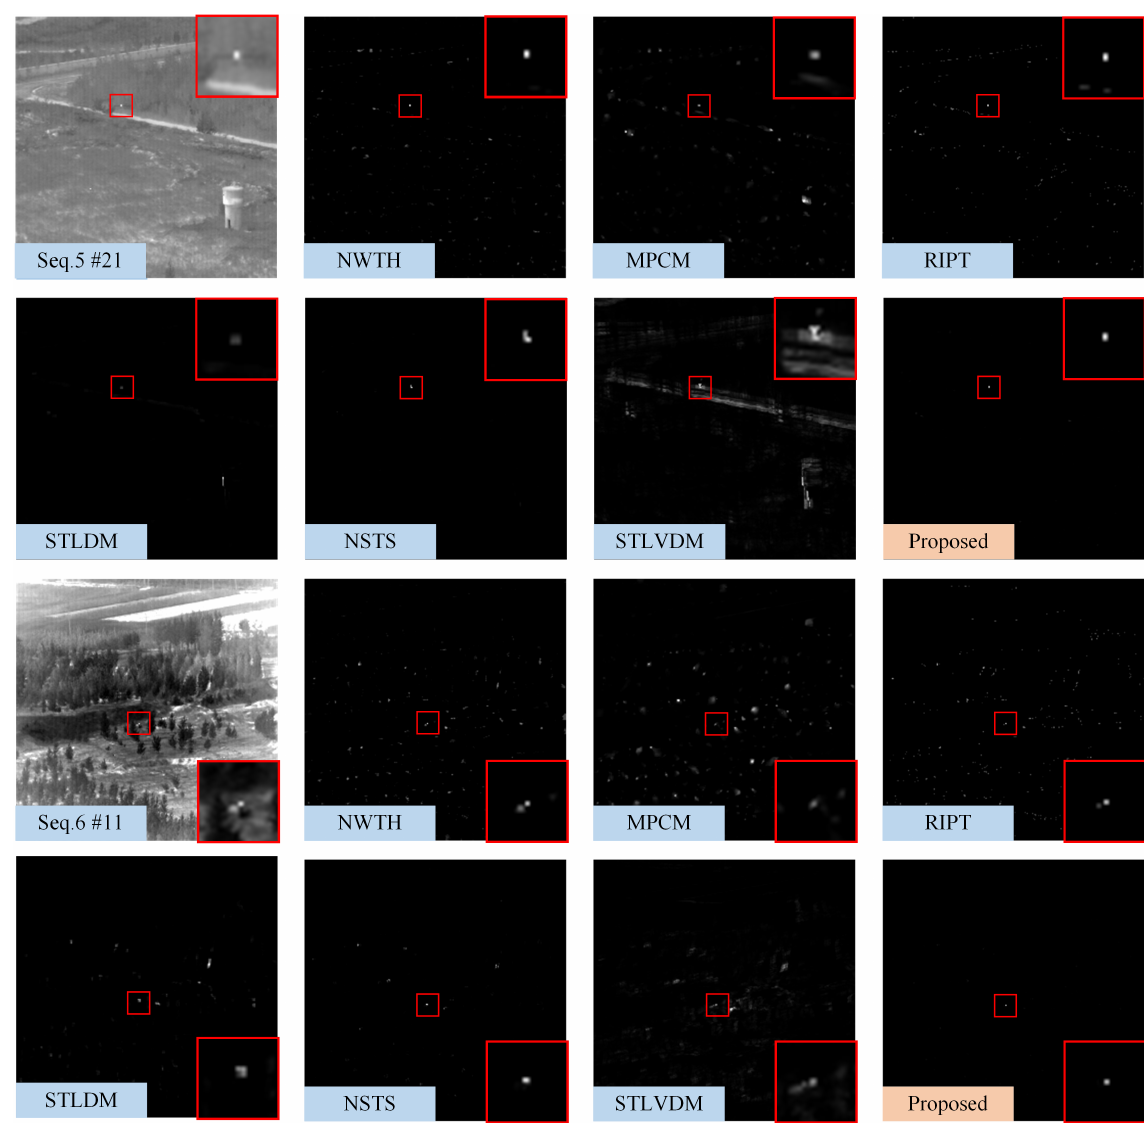
Figure 10. The saliency maps obtained by different methods on 21th frame in Seq.5 and 11th frame in Seq.6. For the sake of clarity, the target regions are marked with red boxes, and a close-up version is shown on each